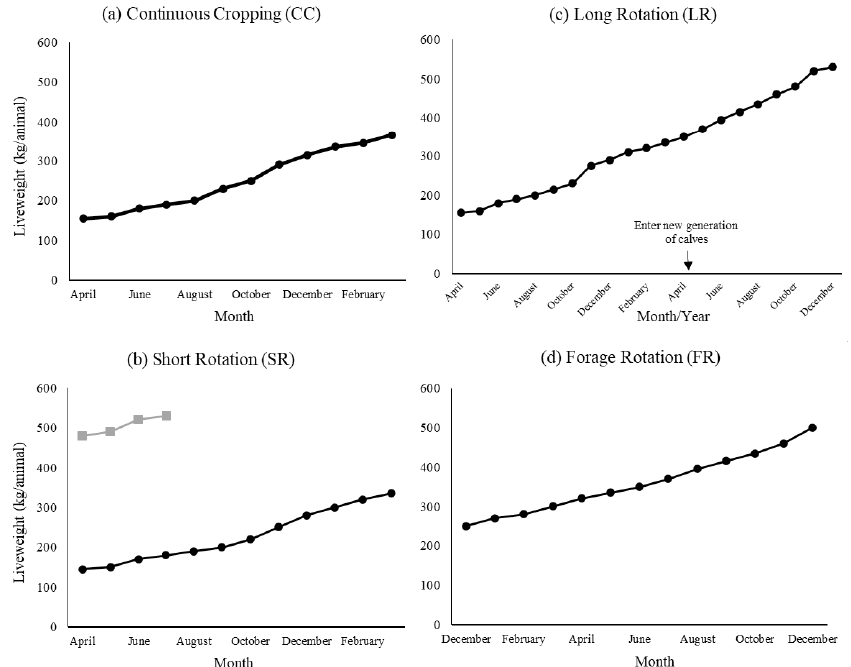
Figure 1. Estimated animal liveweight evolution in the different livestock strategies assigned to each pasture–crop rotation. ( a ) Continuous cropping (CC)–rearing calves; ( b ) Short Rotation (SR)–rearing pasture – crop rotation. ( a ) Continuous cropping (CC) – rearing calves; ( b ) Short Rotation (SR) – rearing heifers (black line) + culled cows (grey line); ( c ) Long rotation (LR) – rearing and finishing streets; ( d ) heifers (black line) + culled cows (grey line); ( c ) Long rotation (LR)–rearing and finishing streets; Forage rotation (FR) – finishing streets. ( d ) Forage rotation (FR)–finishing